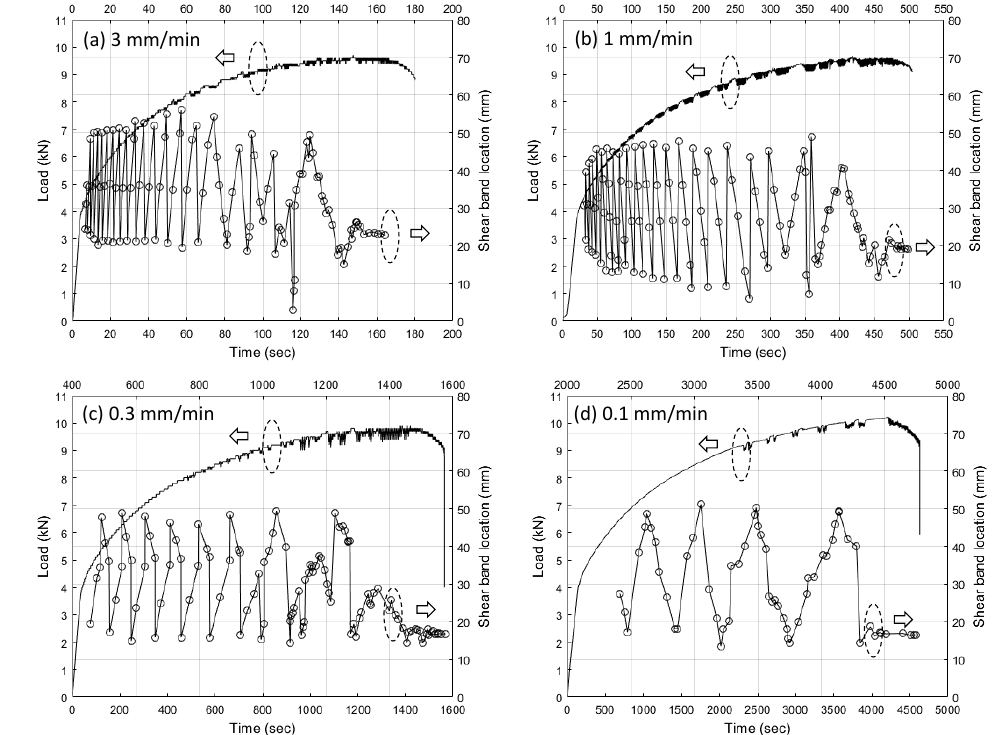
Figure 9. Shear band pattern location on specimen and loading curve. Pulling rate is ( a ) 3.0 mm/min, ( b ) 1.0 mm/min, ( c ) 0.3 mm/min and ( d ) 0.1